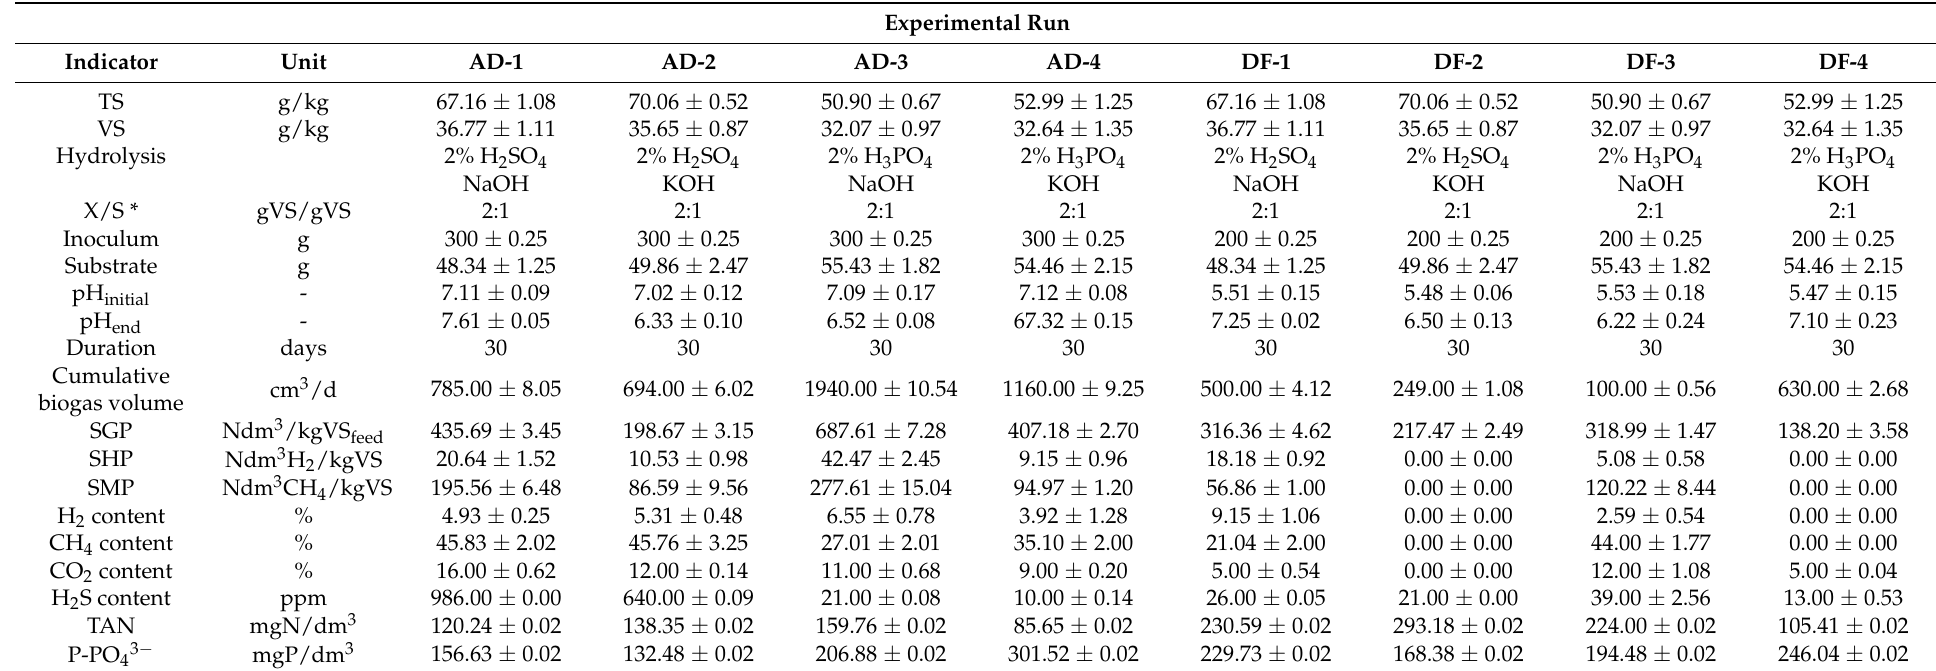
Table 4. Operating parameters and performance of batch tests to establish the optimal inoculum/SBP ratio. Experimental